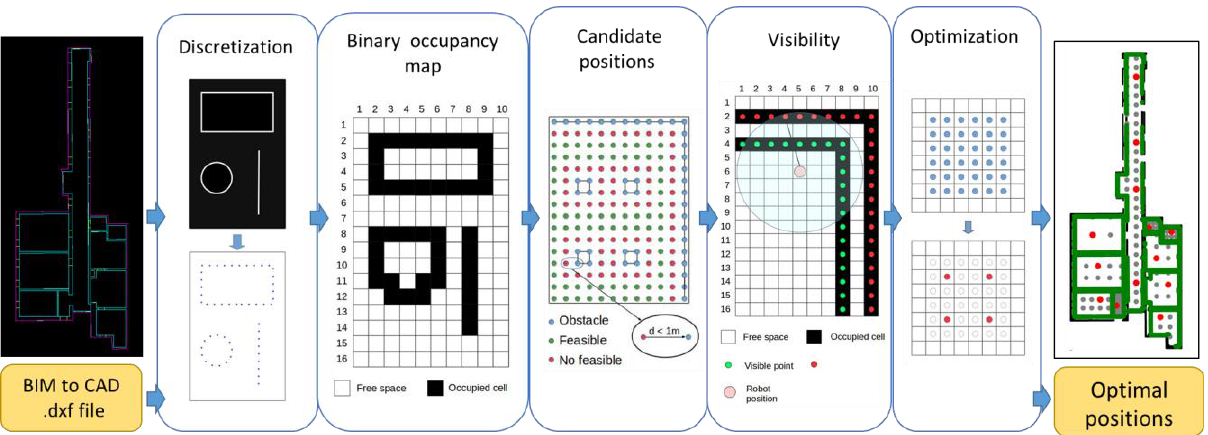
Figure 1. Workflow of the methodology